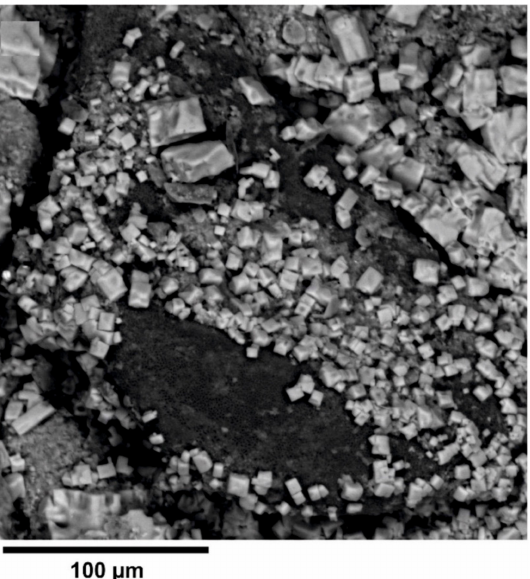
Figure 11. Upper soil horizon (0–3 cm depth) with reddish-yellow iron-rich precipitates and cubic halite crystals on the surface of